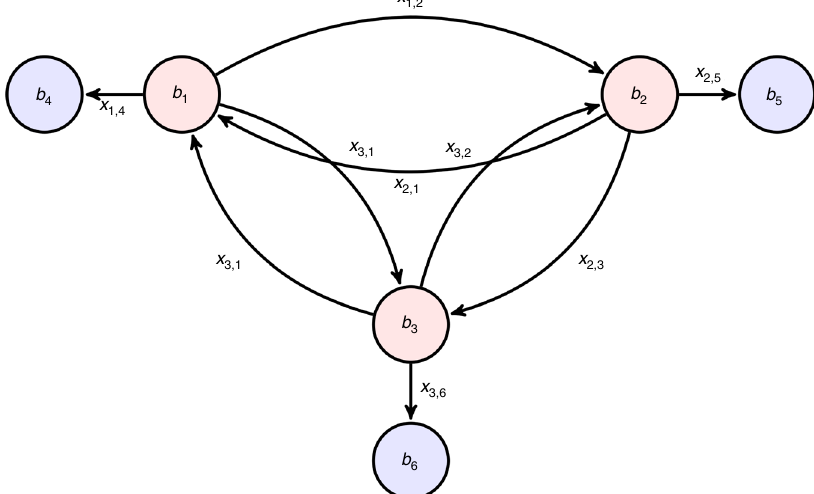
Fig. 7 System model with three hospitals at time t as a directed graph. The system model used for the application to Lima has 41 hospitals, i.e., 41 triage and 41 discharge